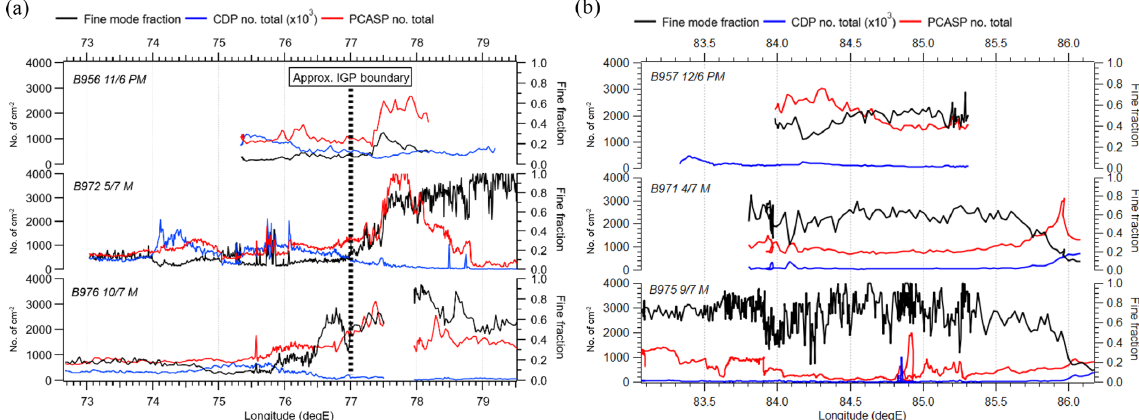
Figure 8. Horizontal variability in aerosol physical properties (CDP no. total, PCASP no. total and fine mode fraction) for pre-monsoon (PM) and monsoon (M) seasons in northern India, from (a) Lucknow to Jaipur/Jodhpur and (b) Lucknow to Bhubaneswar.